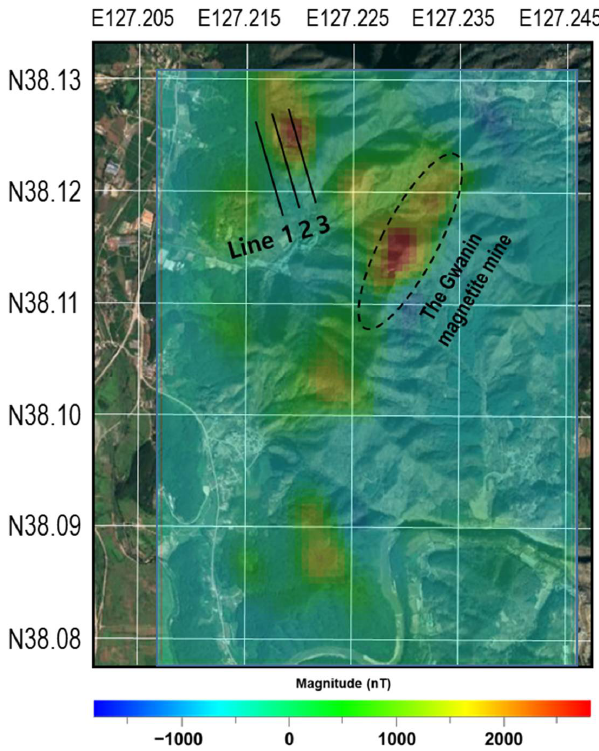
Figure 1. Location of the Yeoncheon titanomagnetite deposit with overlain magnetic anomaly data after RTP obtained by the airborne magnetic survey. The three black solid lines show the location of the electrical resistivity survey, and the black dashed line denotes the location of the Gwanin magnetite mine.